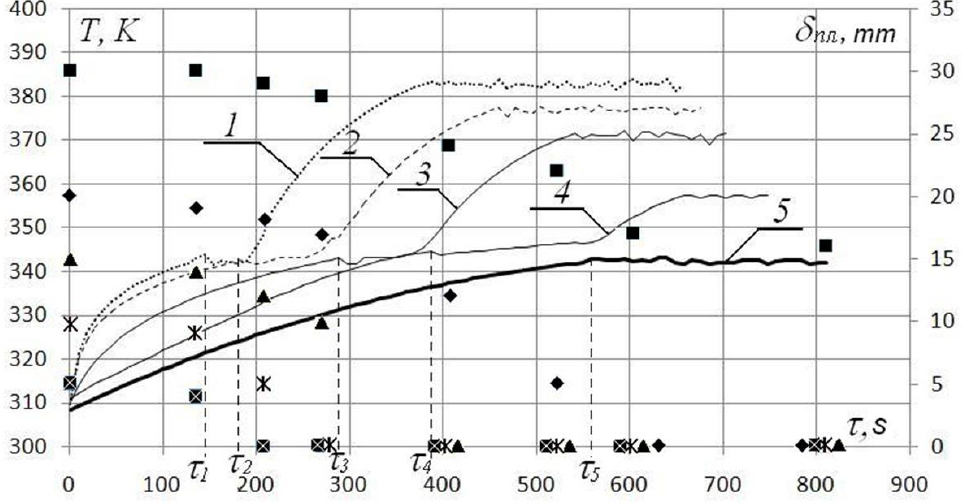
Figure 3 . Temperature of surface of bottom cover and liquid film thickness depending on time. 1( ) – 5mm; 2( ) – 10mm; 3( ) – 15mm, 4( ) – 20mm, 5( ) –